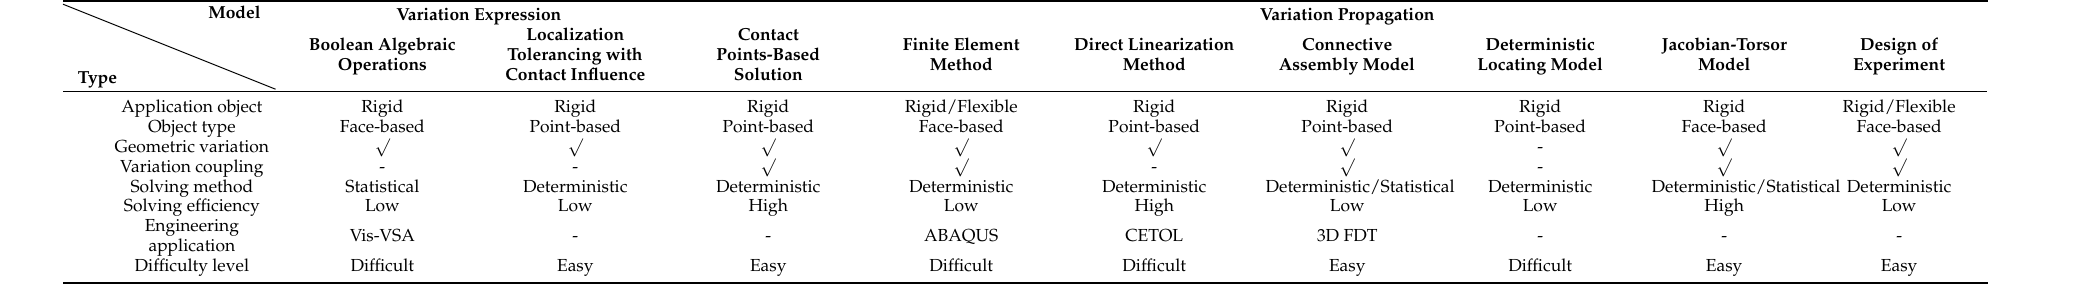
Table 1. Variation models